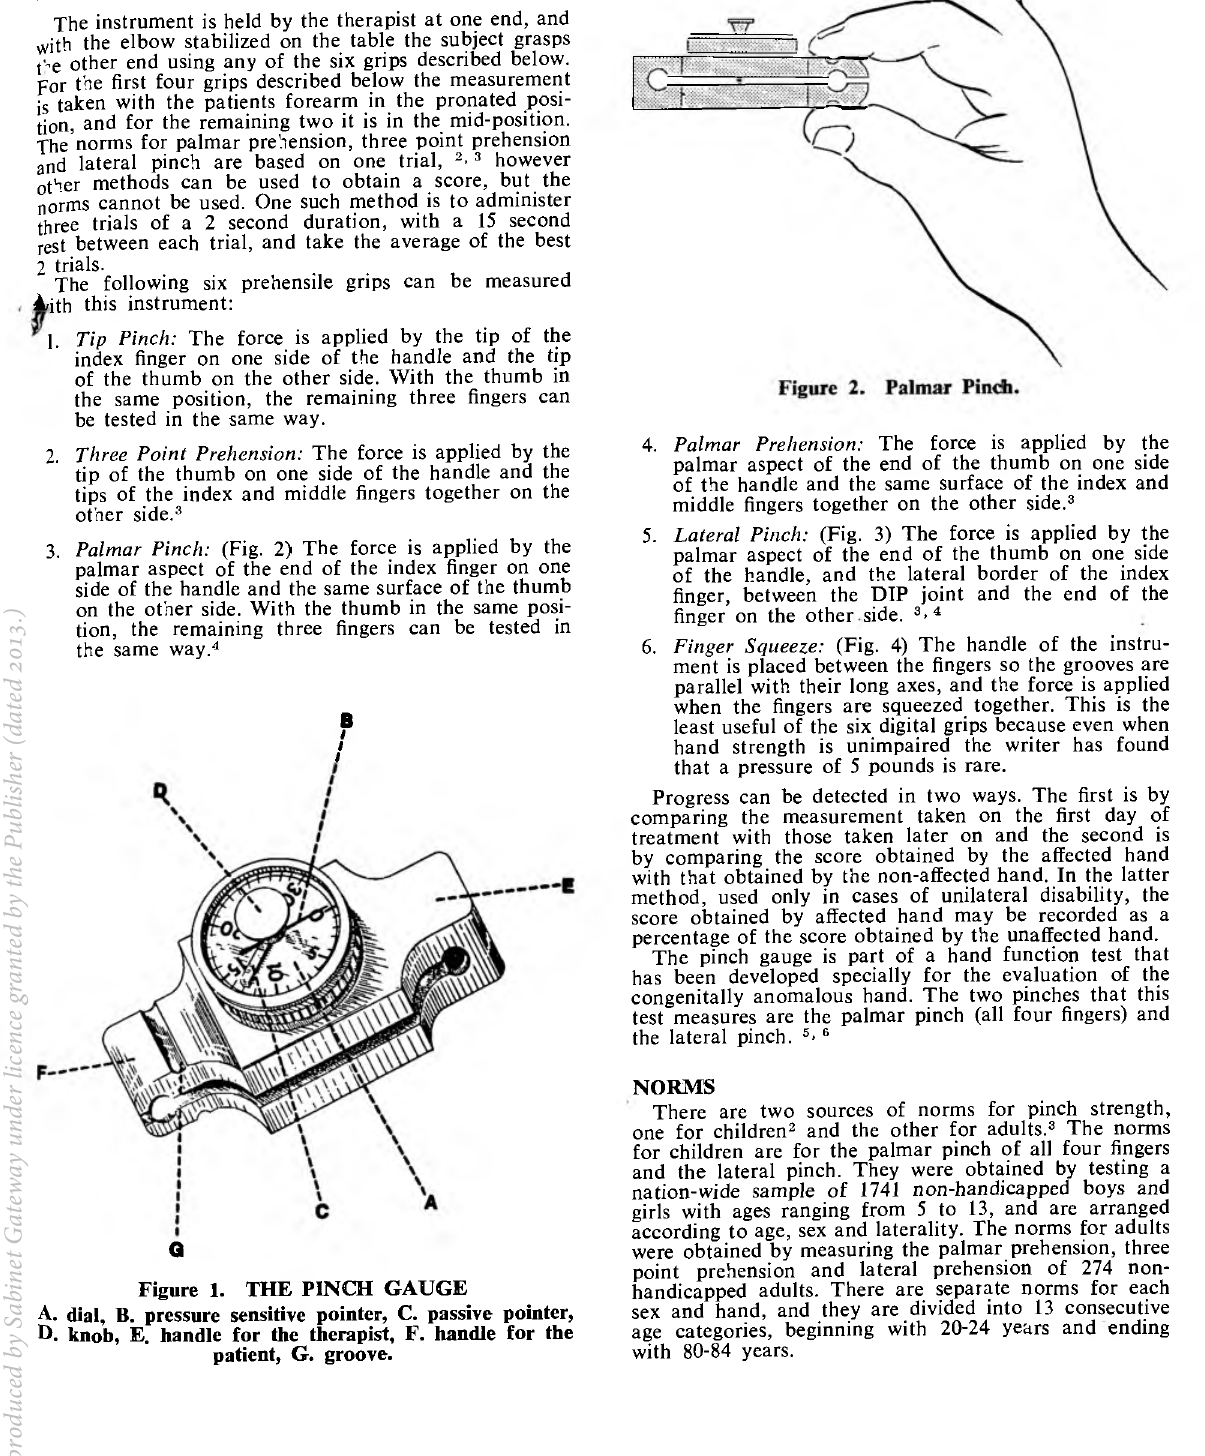
A. dial, B. pressure sensitive pointer, C. passive pointer, D. knob, E. handle for the therapist, F. handle for the patient, G.